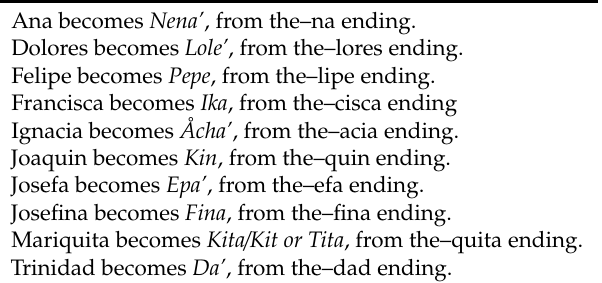
Table 3. Sample of Nicknames from First